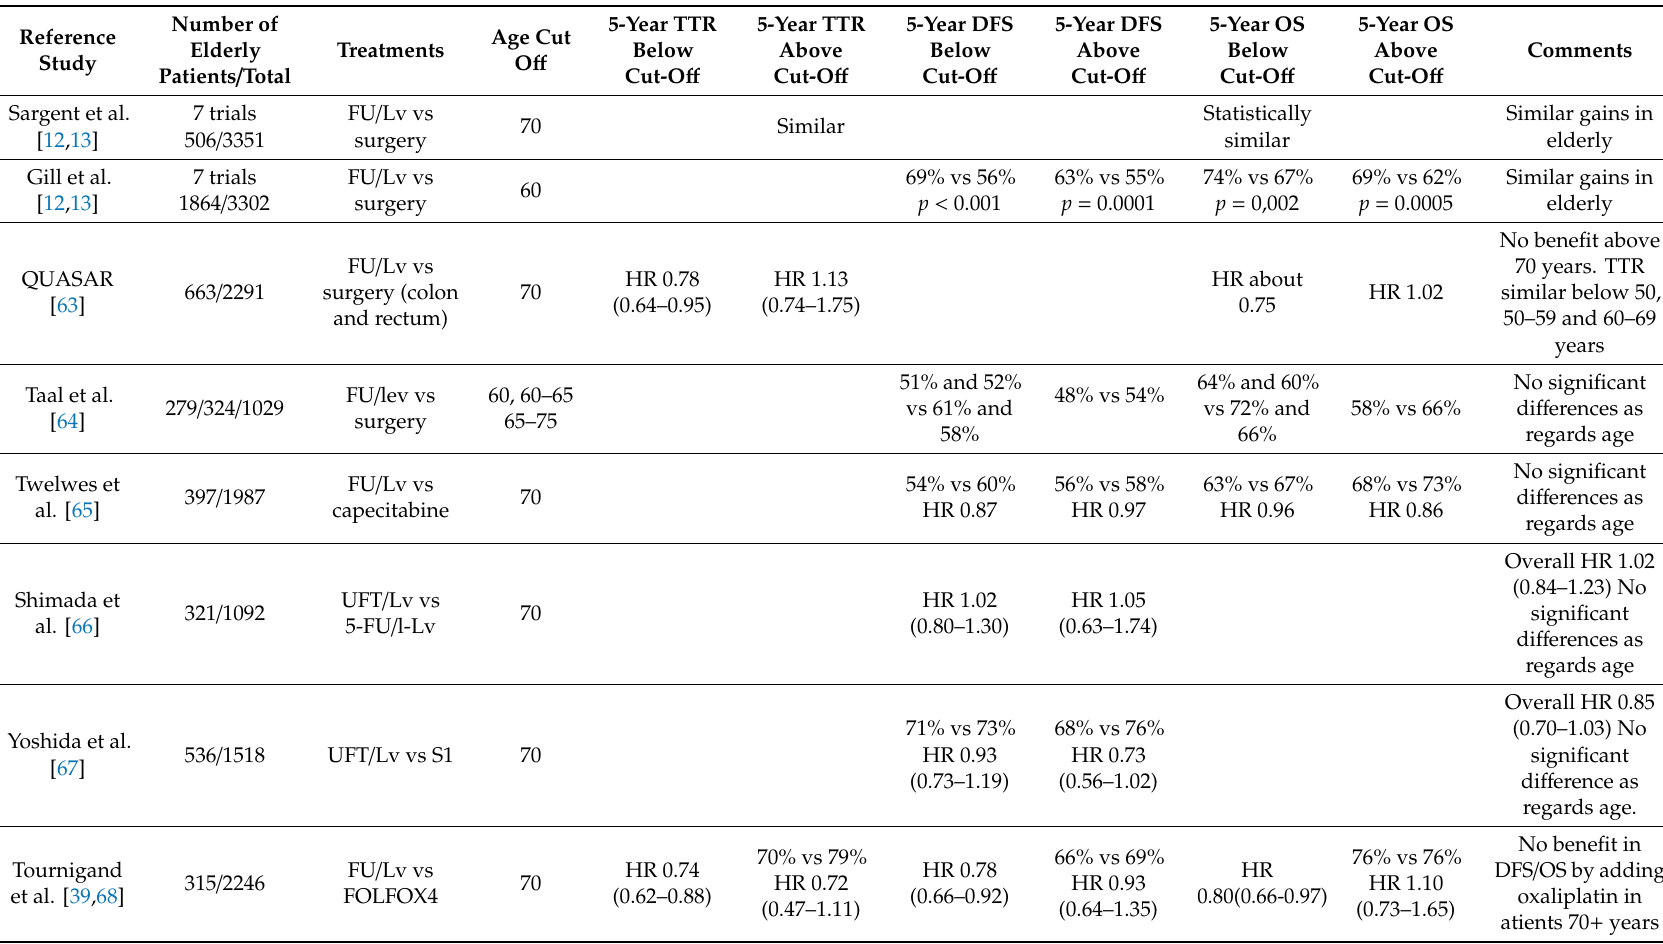
Table 2. Retrospective analyses of the importance of age as regards the benefit of adjuvant chemotherapy in randomized trials and in pooled analyses of trials with patients treated for colon